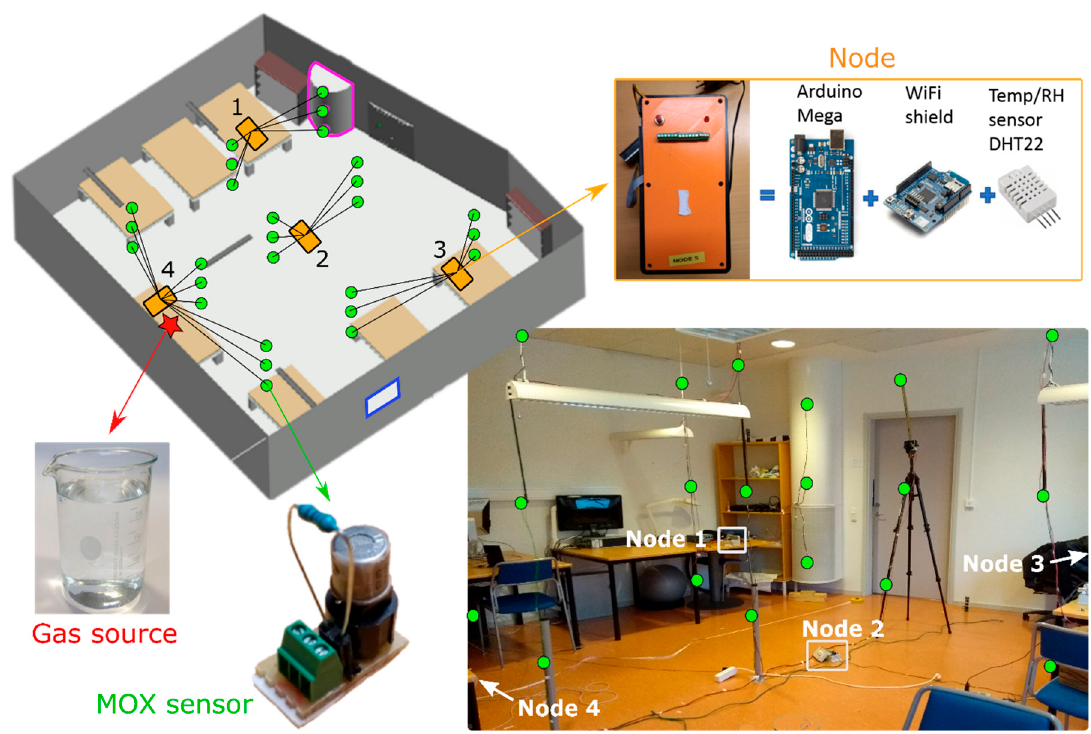
Figure 1. Test room (CAD drawing, key elements and photo). The 27 MOX sensors (Models: TGS 2600 (×7), 2602 (×7), 2610 (×5), 2611 (×2) and 2620 (×6), Figaro Engineering Inc., Osaka, Japan) are depicted as green circles, and the processing nodes as orange rectangles. The door and window were closed during the